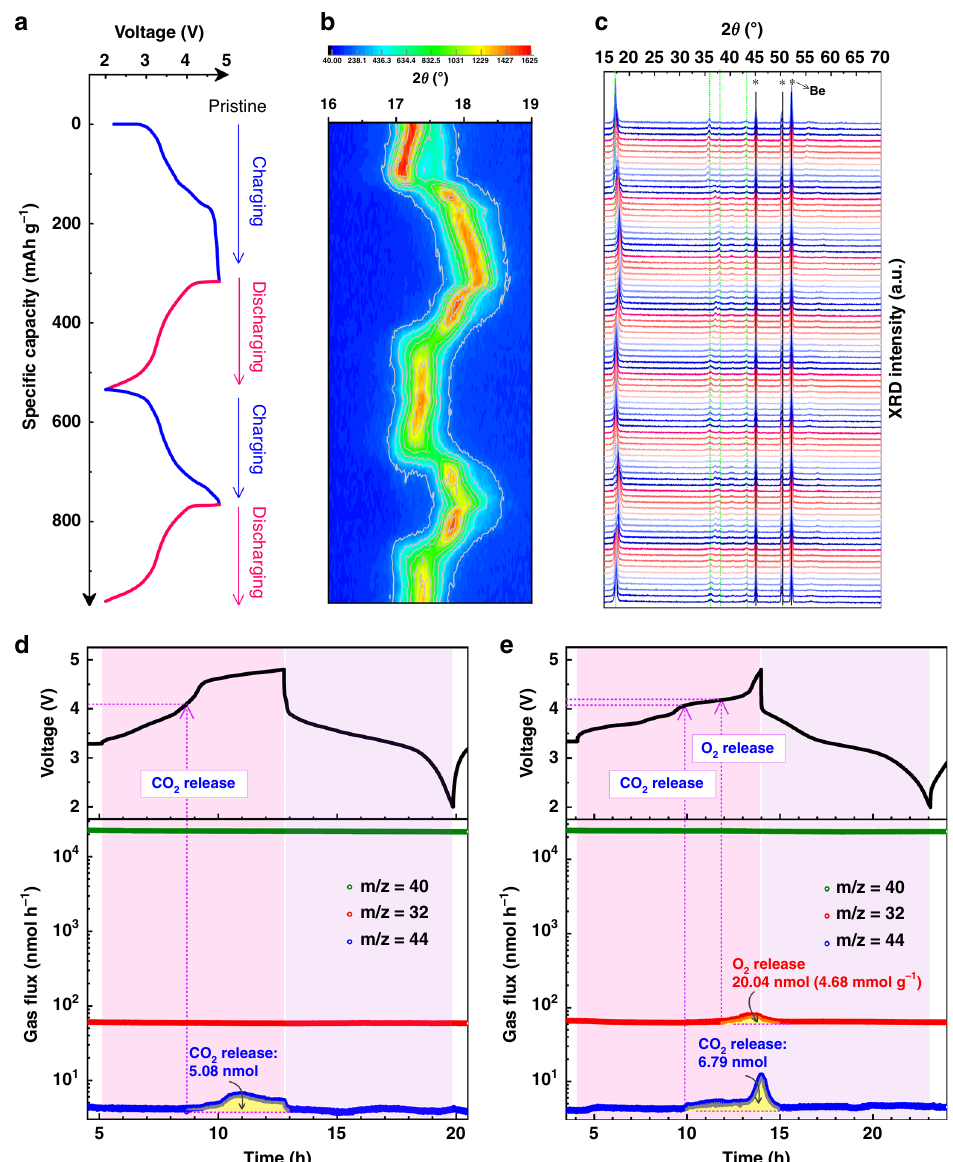
Fig. 6 In situ XRD and in situ DEMS results. a Voltage pro fi les used for in situ XRD analysis for ID-Li 2 RuO 3 at a current density of 30 mA g – 1 . b Contour plot of in situ XRD patterns in the range of 2 θ = 16° – 19°. The diffraction intensity is represented by the color depth. c in situ XRD patterns from the direct observations. The peaks marked with stars are attributed to the beryllium X-ray input window of the in situ cell. d , e Gas evolution at a current density of 30 mA g – 1 in the ID-Li 2 RuO 3 ( d ) and R-Li 2 RuO 3 ( e ) vs. Li cells from in situ DEMS